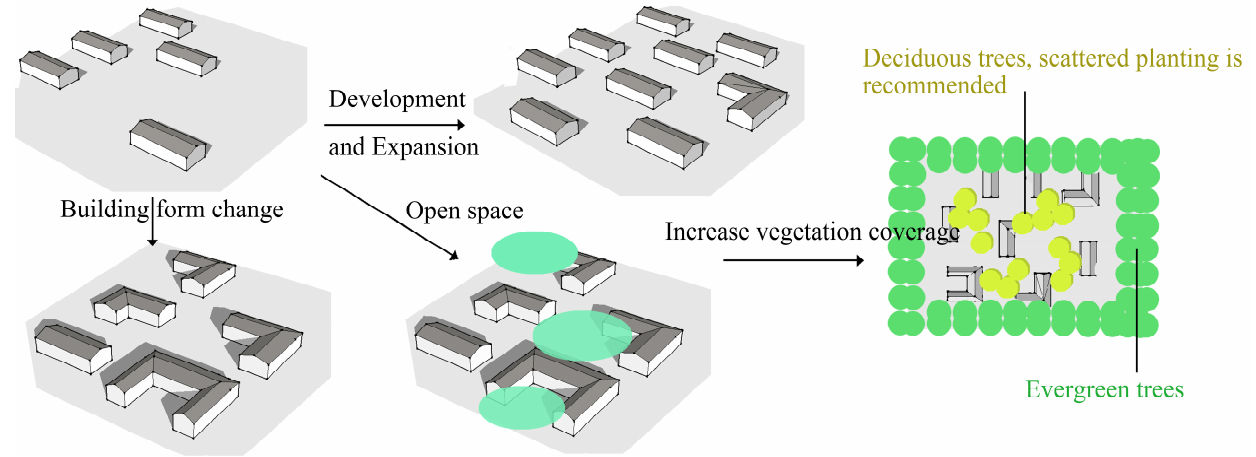
Figure 17. Suggestions for improving the thermal comfort of Linpan.